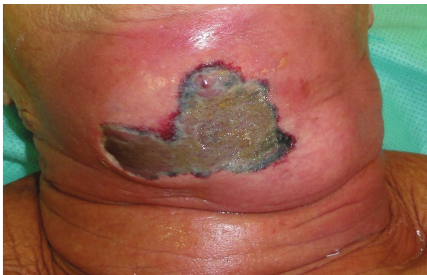
Figure 1: The extraoral physical examination revealed extensive necrotic tissue in the cervical area.